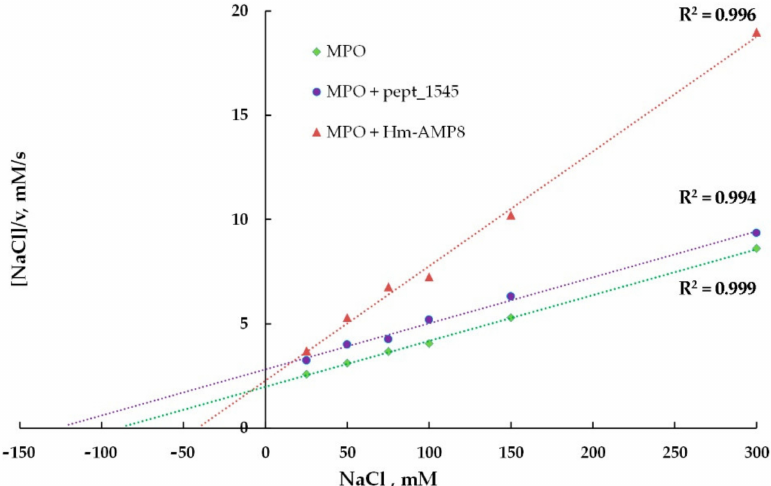
Figure 11. Hanes–Woolf plot illustrating the effects of 8 µ M pept_1545 and 0.8 µ M Hm-AMP8 on kinetics of MPO-catalyzed Cl – oxidation ( n = 3). The concentrations were as follows: 0.8 nM MPO